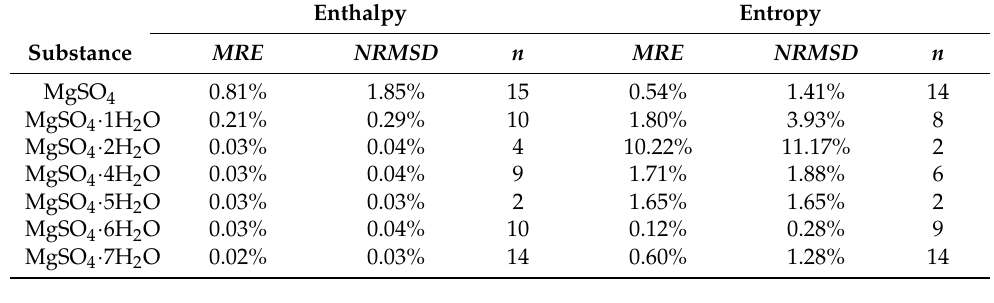
Table 9. Statistical error and deviations of the fitted enthalpy and entropy with the CMA-ES method, n is the number of compared points or population. Enthalpy Entropy Substance